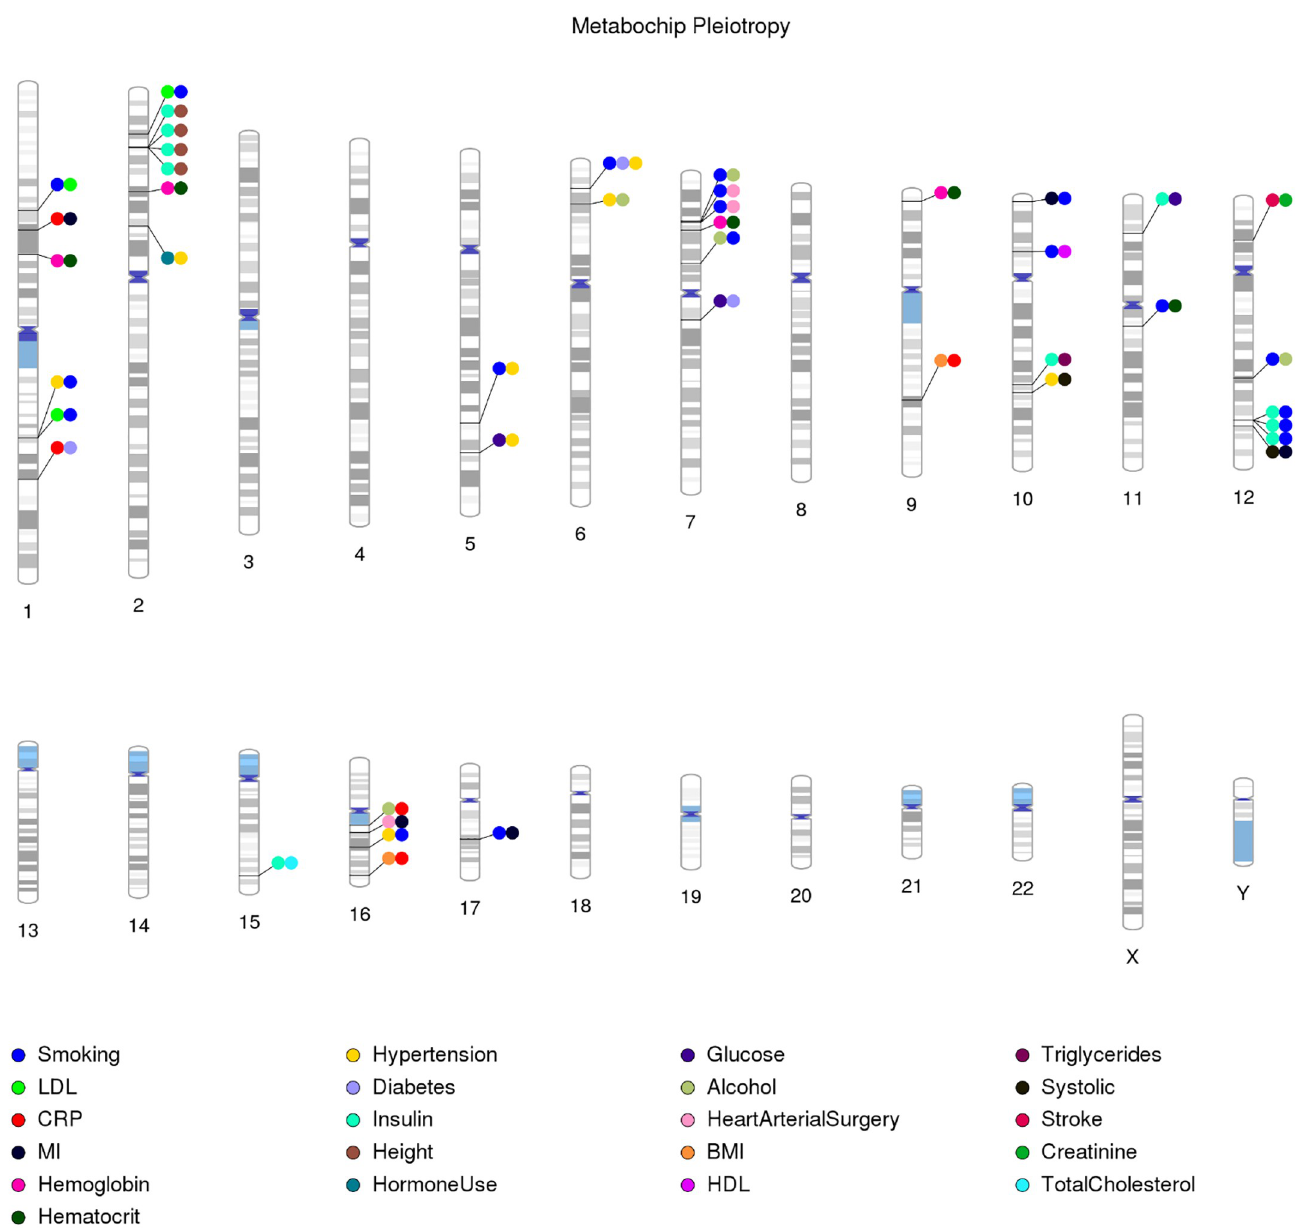
Fig 6. Phenotype classes associated with the same single nucleotide polymorphism in African Americans from the Population Architecture using Genomics and Epidemiology (PAGE) study. A plot of the 43 PheWAS results where two or more phenotype classes were significantly associated (p < 0.01) with the same single nucleotide polymorphism (SNP) in participating PAGE study sites. This plot does not include concomitant lipid phenotype-class results (53 SNPs) or white blood cell related results for chromosome 1 (37 SNPs). Lines connect the SNP chromosomal location to circles, and the color of each circle corresponds to an associated phenotype class listed in the legend at the